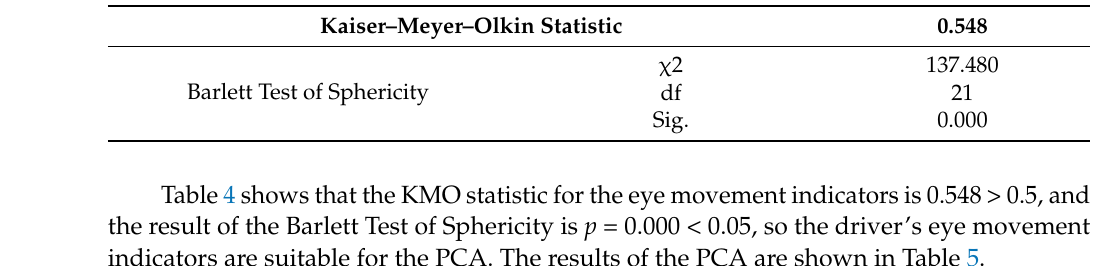
Table 4. KMO test and Barlett Test of Sphericity for eye movement indicators.